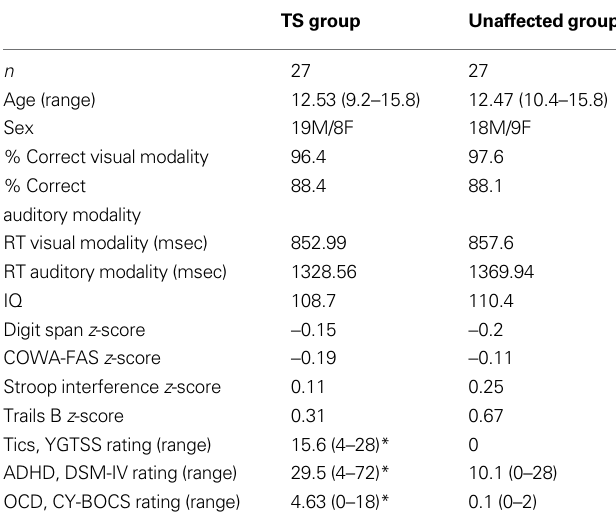
Table 1 | Group characteristics of adolescents with and without TS.